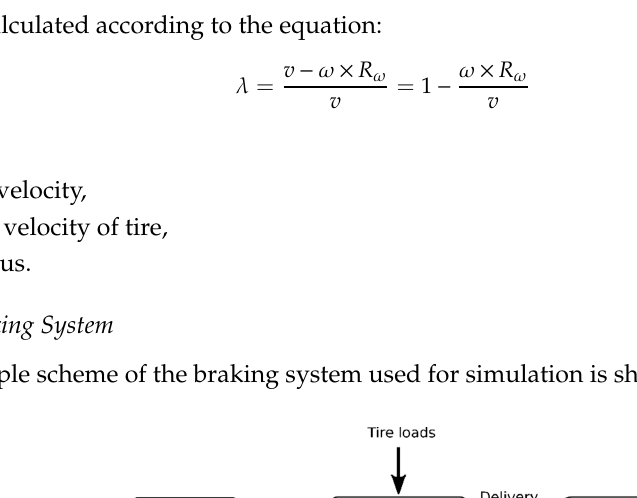
Figure 1. Slip characteristics of tires with radial construction.